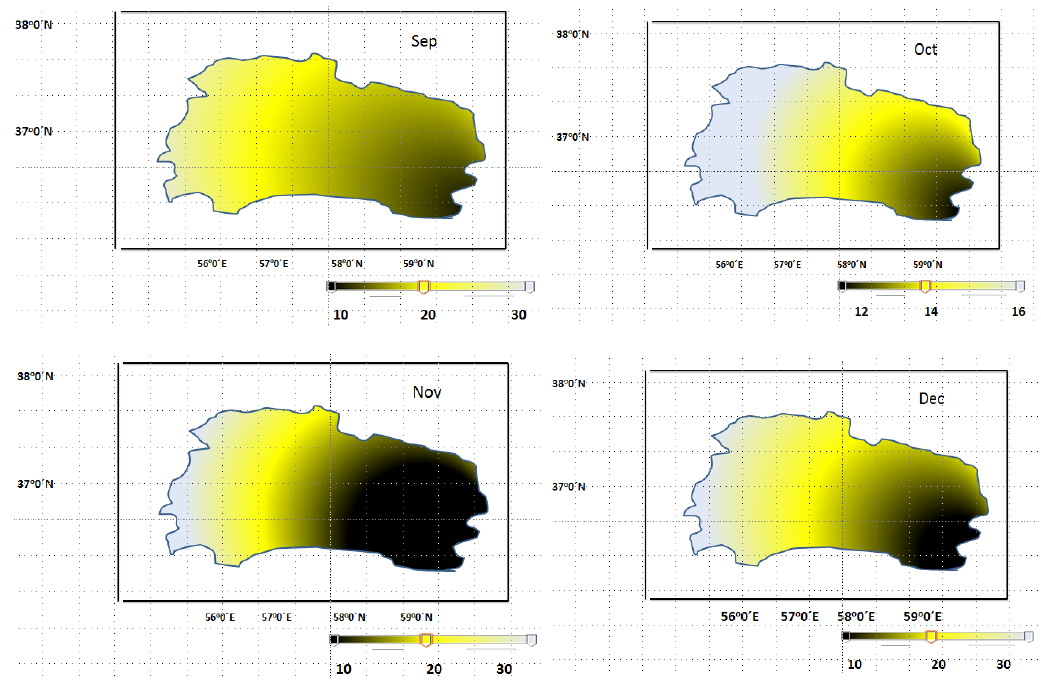
Figure 2. Monthly rainfall for the basin.